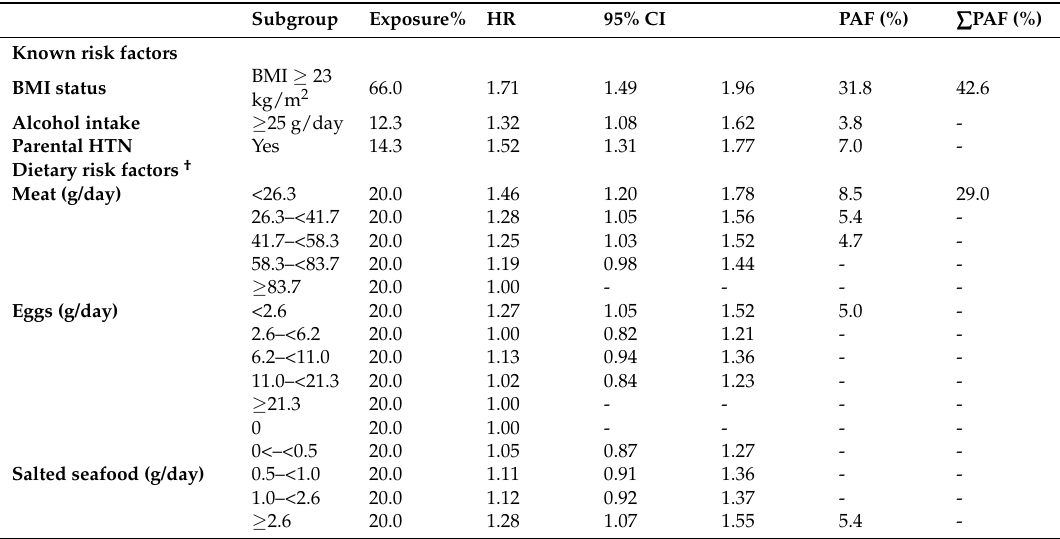
Table 3. Population-attributable risks of potential risk factors for incident